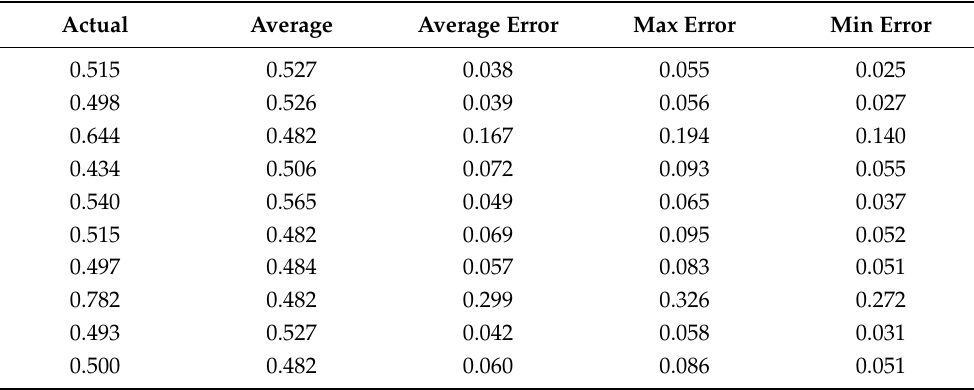
Table A79. Set 2, trials 1–10 data (single 0.5 PR